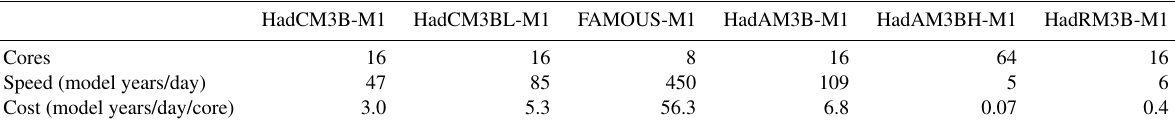
Table 3. Computational performance of M1